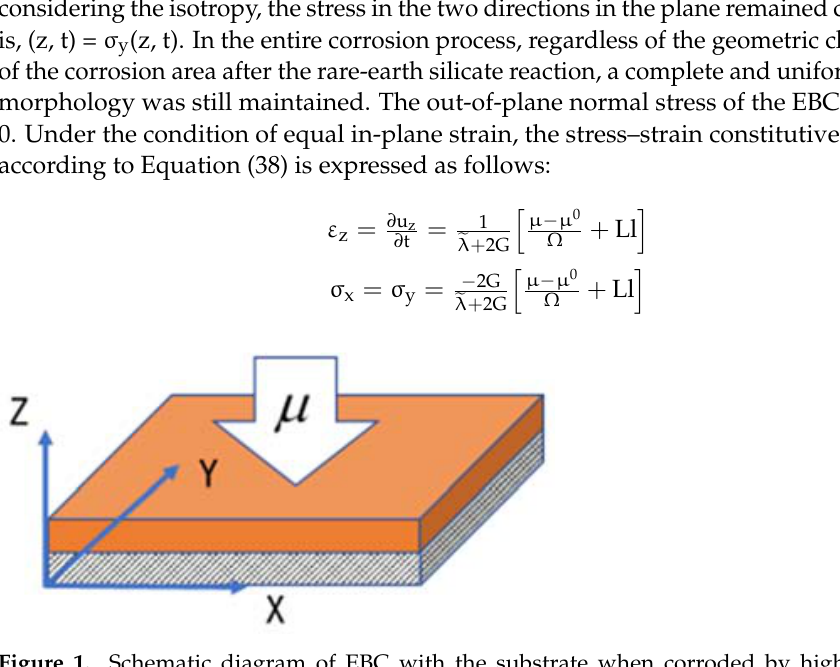
Figure 1. Schematic diagram of EBC with the substrate when corroded by high-temperature water vapour.